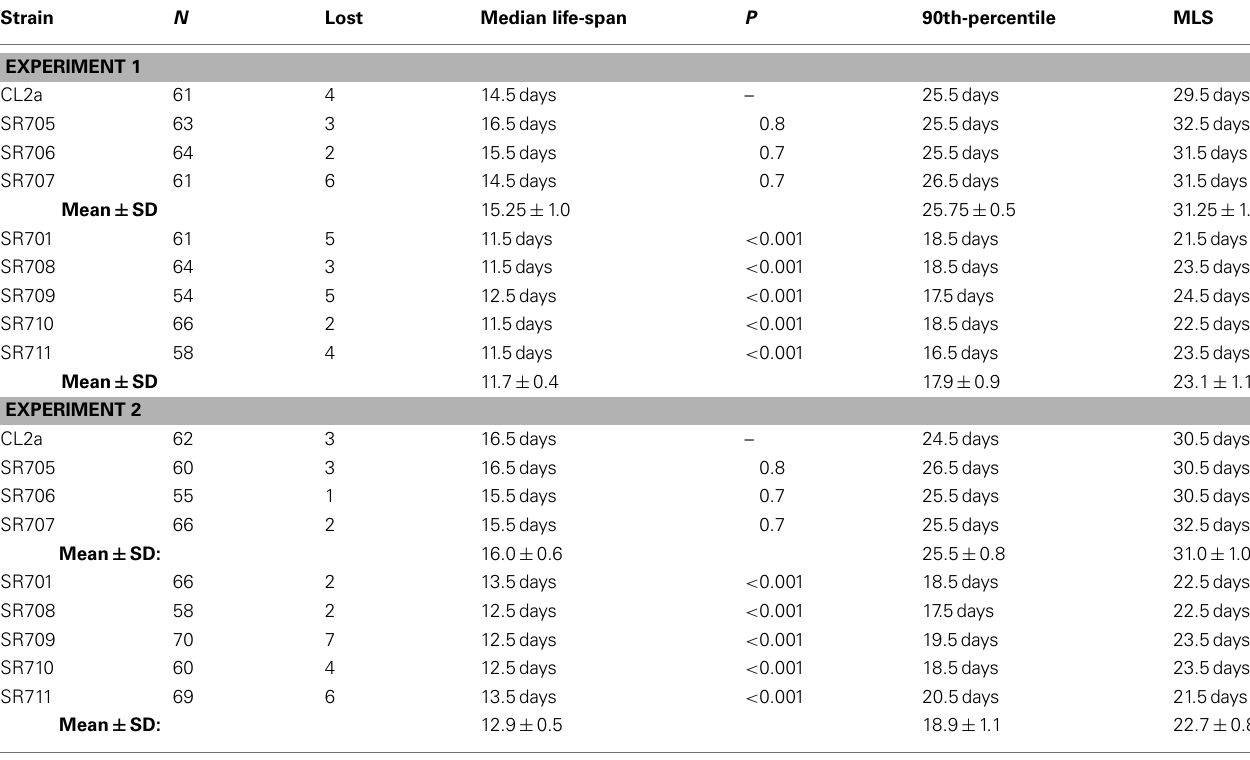
Table 1 | Survival data for lsq4 recombinant-congenic lines in liquid medium. Strain N Lost Median